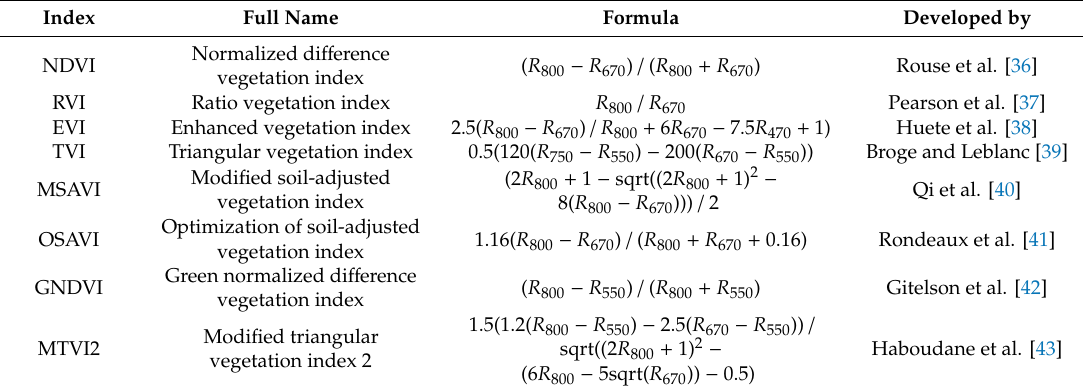
Table 3. Summary of spectral indices used in this